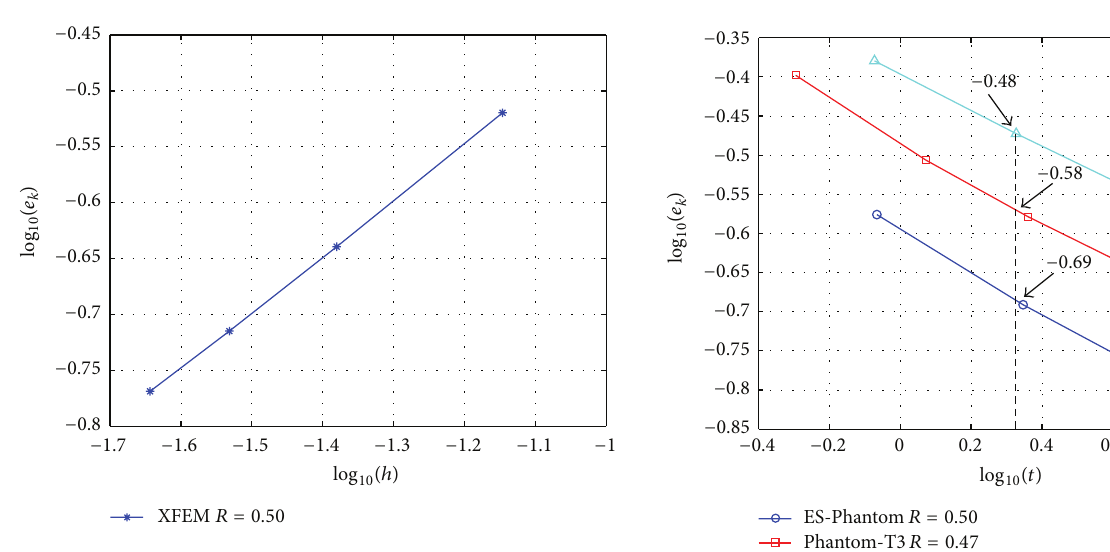
Figure13:Theconvergenceinthestressintensityfactor 𝐾 𝐼 ofXFEM versus ℎ (mesh size) for the sheet with edge crack under tension.